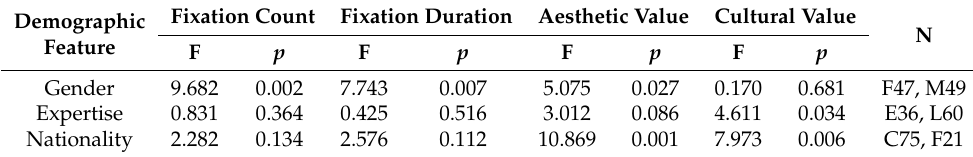
Table 4. Demographic differences in eye movement and landscape value